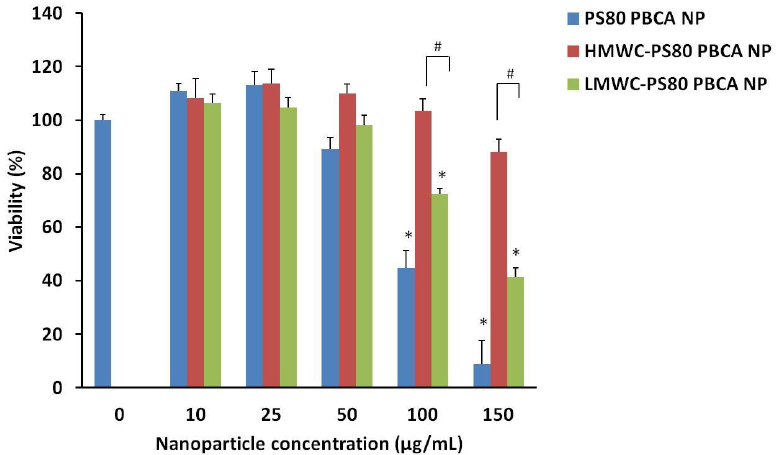
Figure 5. The cytotoxicity of mouse iPSCs to the nanoparticles at different concentrations was de- termined by the Cell Counting Kit-8. A cell viability of 90% or above was observed for 25 µg/mL of PS80 PBCA NP, 50 µg/mL of (0.01% w / v ) LMWC-PS80 PBCA NP and 150 µg/mL of (0.01% w / v ) of PS80 PBCA NP, 50 µ g/mL of (0.01% w / v ) LMWC-PS80 PBCA NP and 150 µ g/mL of (0.01% w / v ) HMWC-PS80 PBCA NP. N = 4; * p < 0.01, # p < 0.001. HMWC-PS80 PBCA NP. N = 4; * p < 0.01, # p < 0.001.